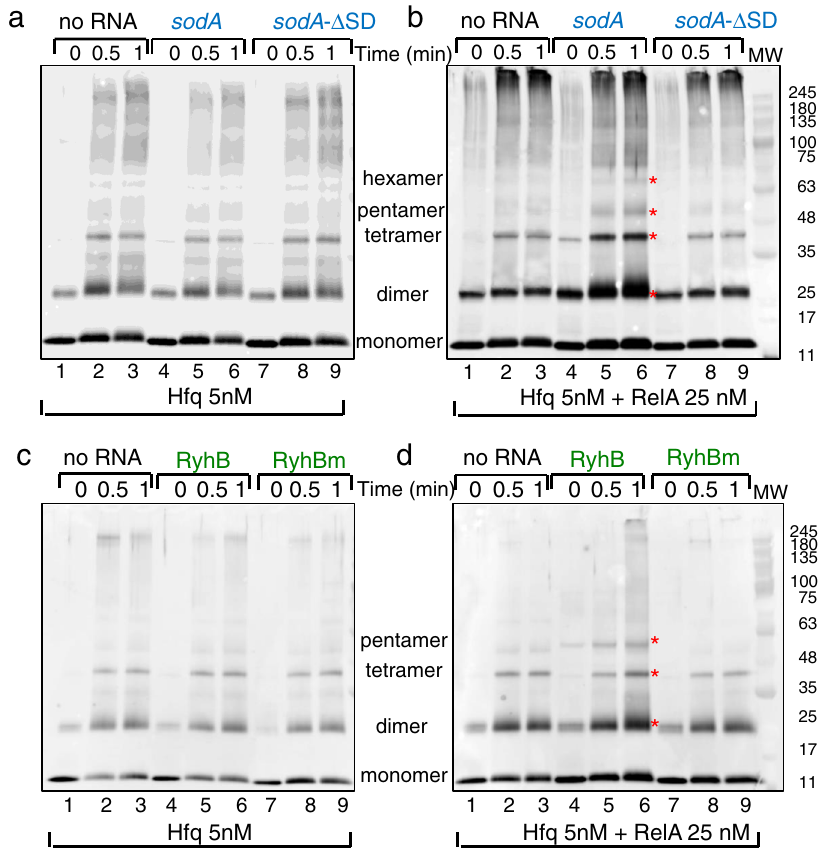
Fig. 4 RelA-mediated Hfq assembly requires interaction with GGAGA sequence (western using α Hfq antibody). a , c In the absence of RelA, RNA has no effect on Hfq multimerization. Reactions of Hfq incubated without or with RNA (100 nM) at 22 °C for 10 min were UV crosslinked followed by protein crosslinking with 0.2% of glutaraldehyde (Time in min indicates duration of protein crosslinking). The proteins separated in 4 – 20% MOPS gradient gels were detected using α Hfq antibody. b , d RelA induces Hfq multimerization when presented with RNA carrying GGAGA. Reactions of Hfq incubated with RelA, without or with RNA including RyhB (90 nt), RyhBm (90 nt) sodA (98 nt), and sodA - Δ SD (47 nt) were treated as in a . Asterisk indicates the formation of new Hfq multimers detected using wild type RNAs in the presence of RelA. Source data provided as a source data fi